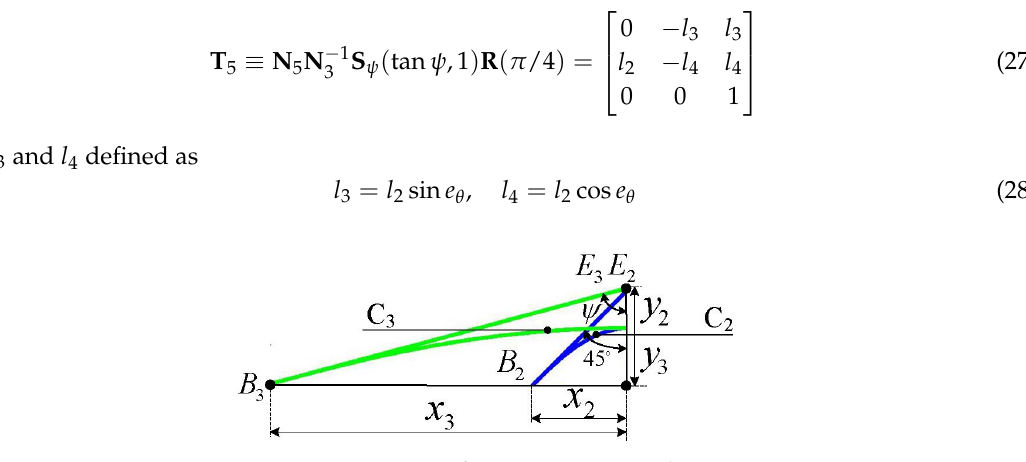
Figure 8. Zoom-in of Lamé curves C 2 and C 3 .